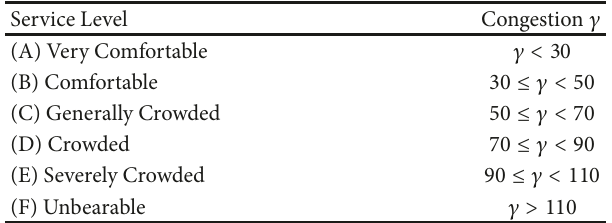
Table 5: Congestion range corresponding to the six service levels. Service